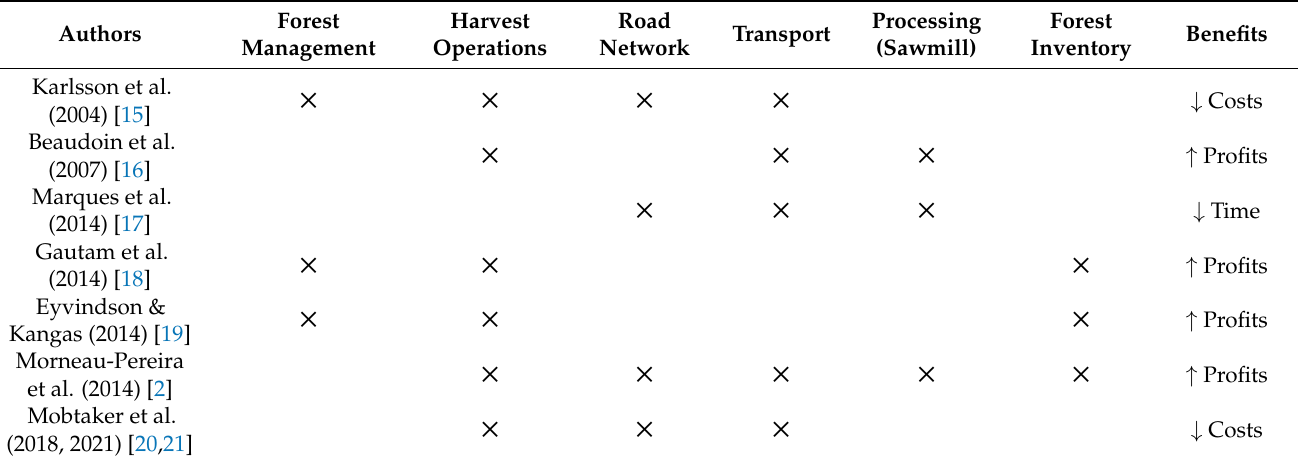
Table 1. Elements considered and benefits of relevant